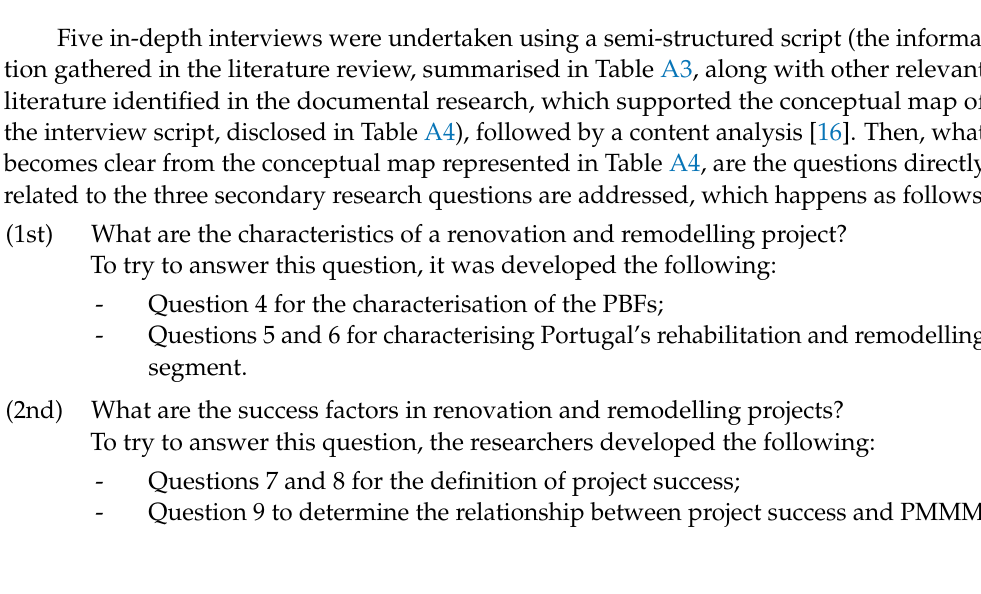
Figure 1. Research model proposal (source: own).